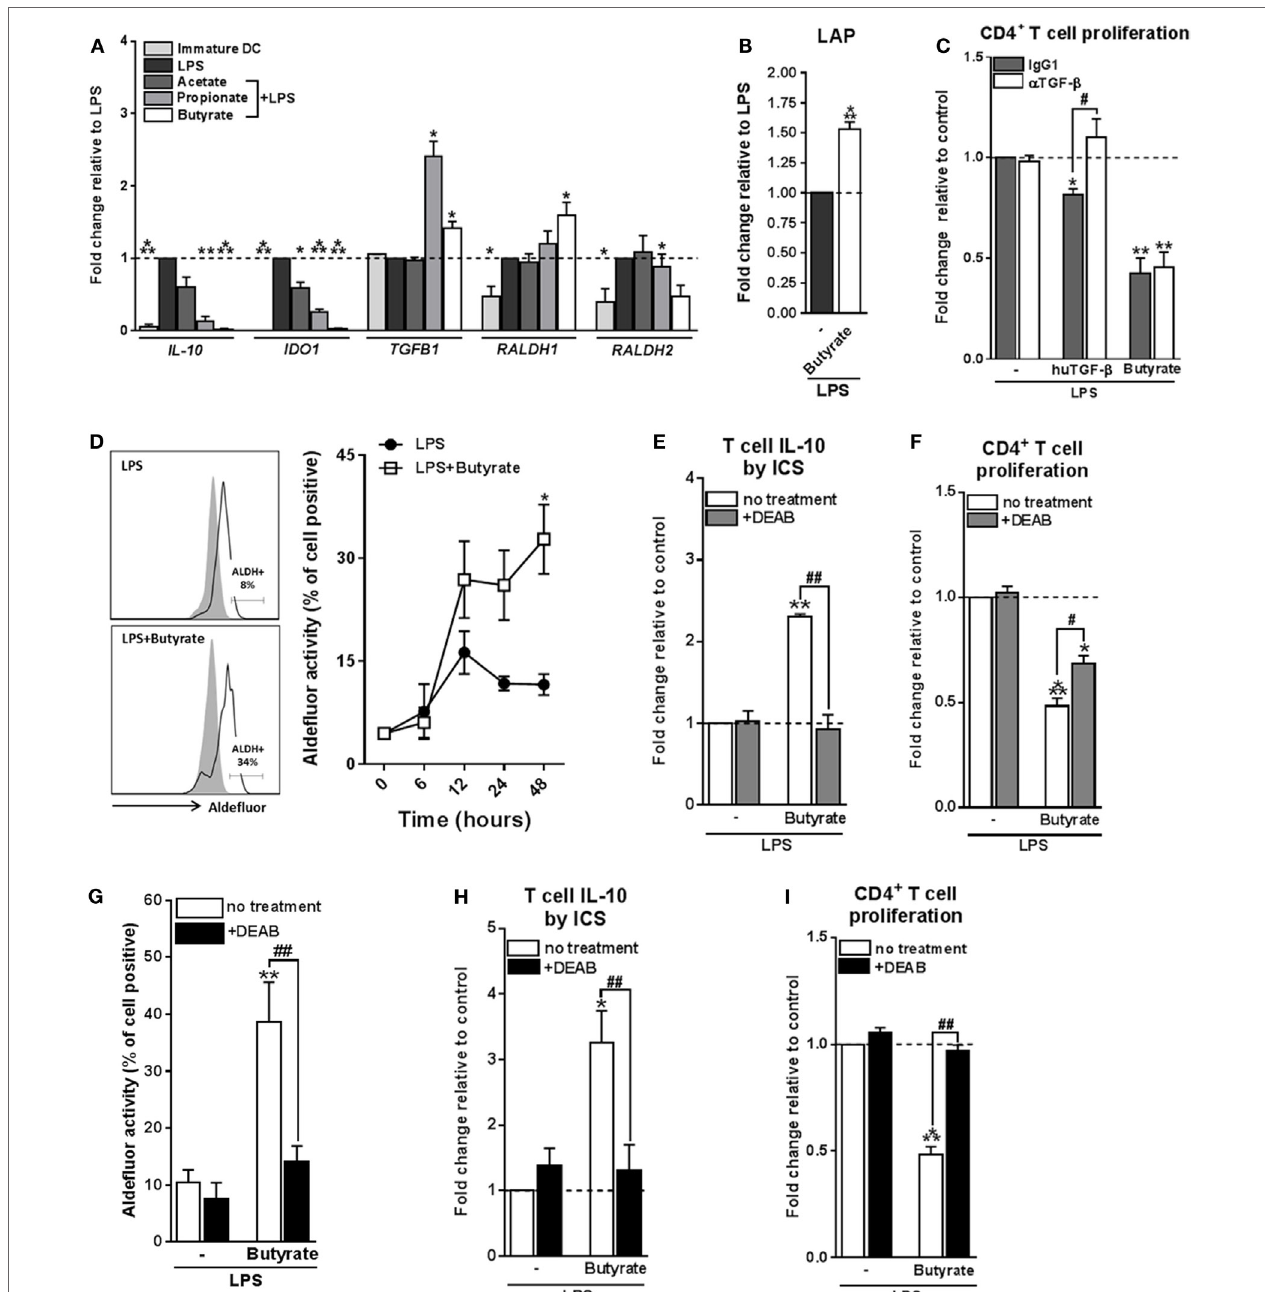
FigUre 3 | Type 1 regulatory T cell induction by butyrate-conditioned human dendritic cells (DCs) depends on retinaldehyde dehydrogenase 1 (RALDH1) expression. (a) mRNA expression of indicated genes was quantified using real-time qPCR of monocyte-derived DCs stimulated for 16 h. (B) Relative membrane bound latency- associated peptide (LAP) expression on DCs stimulated with indicated reagents as determined by flow cytometry. (c) T-cell suppression assay as described in Figures 2D , (F) blocking antibody of human TGF- β was added during the co-culture of DCs with T cells. Human TGF- β was taken along as positive control. (D) Retinaldehyde dehydrogenase (RALDH) activity in DCs was assessed using an Aldefluor assay with a readout by flow cytometry. Representative histograms of RALDH activity 48 h after stimulation are shown on the left, with gray shaded histograms and black lines representing DCs in which RALDH activity was assessed in the presence or absence of reversible RALDH inhibitor diethylaminobenzaldehyde (DEAB), respectively. Right graph: RALDH activity was measured at different times after stimulation and frequencies of DCs positive for RALDH activity are depicted. * p < 0.005 based on two-way ANOVA test. (e) IL-10 production by T cells as described in Figure 2B or (F) T-cell suppression assay as described in Figure 2D , but with the addition that DEAB or vehicle control was added during the DC–T cell coculture. (g) RALDH activity assay as described in Figure 3D , but during stimulation DEAB or vehicle control were added. (h,i) Same as (e,F) , but now DEAB was added during stimulation of DCs with LPS ± butyrate. (a–i) Bar graphs represent means ± SEM of at least three experiments and (a–c,F,g,i) are shown as fold change relative to control conditions. *,# p < 0.05, **,## p < 0.01, *** p < 0.001 for significant differences with the control (*) or between test conditions ( # ) based on paired Student’s t